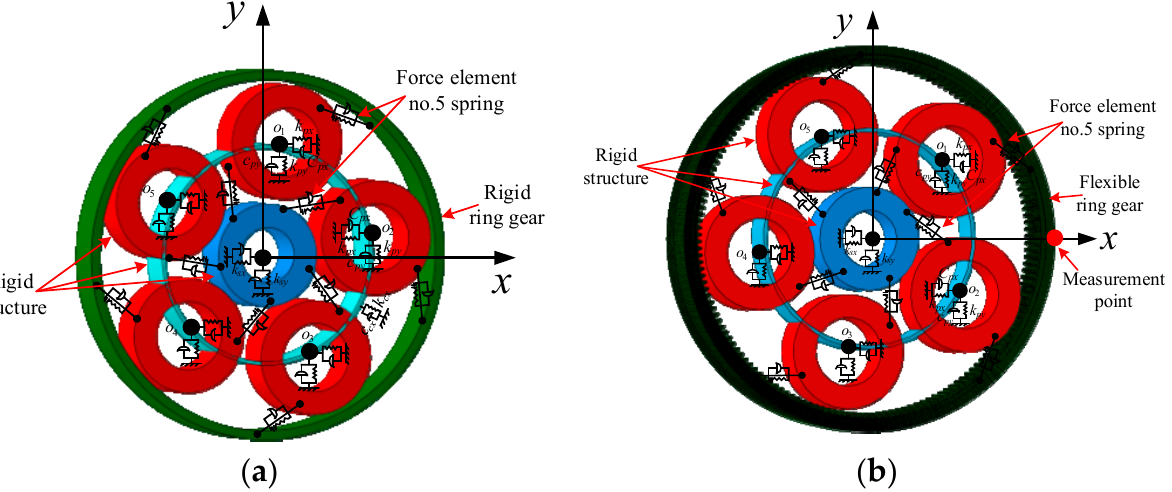
Figure 3. Simulation model of planetary transmission system in SIMPACK. ( a ) Rigid coupling model and ( b ) rigid-flexible coupling model.